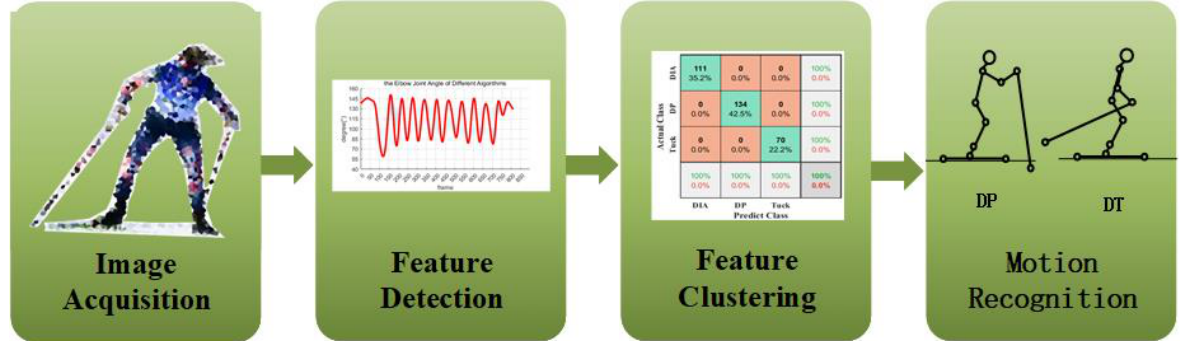
Figure 2. Architecture of monitoring recognition for skiing state.